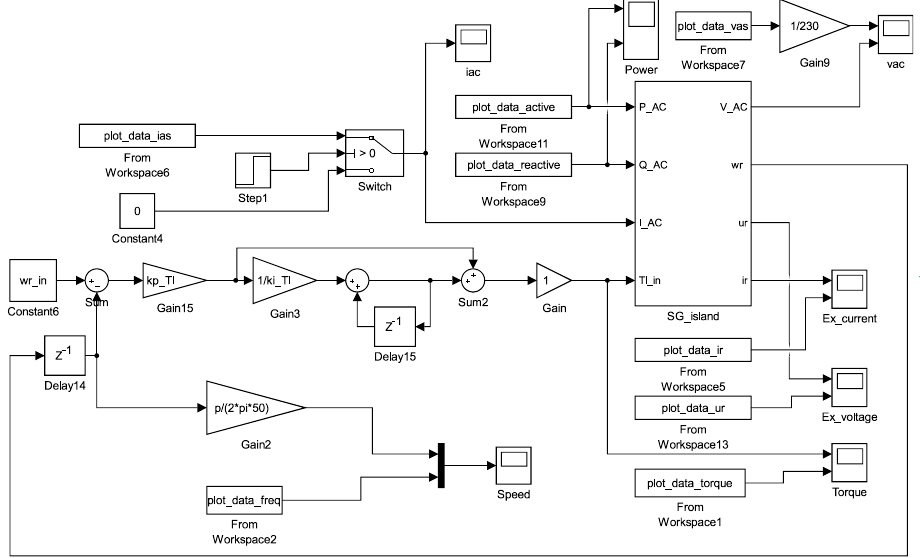
Figure 2. MATLAB/Simulink I/O signals of the synchronous generator model emulated by the